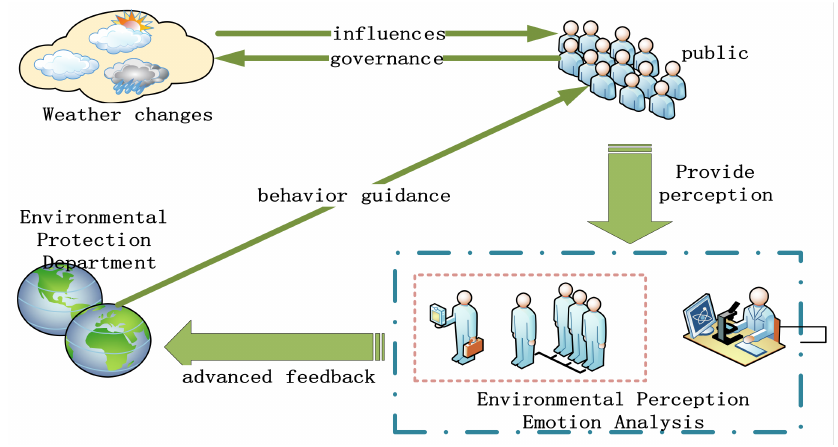
Figure 1. Environmental emotion perception